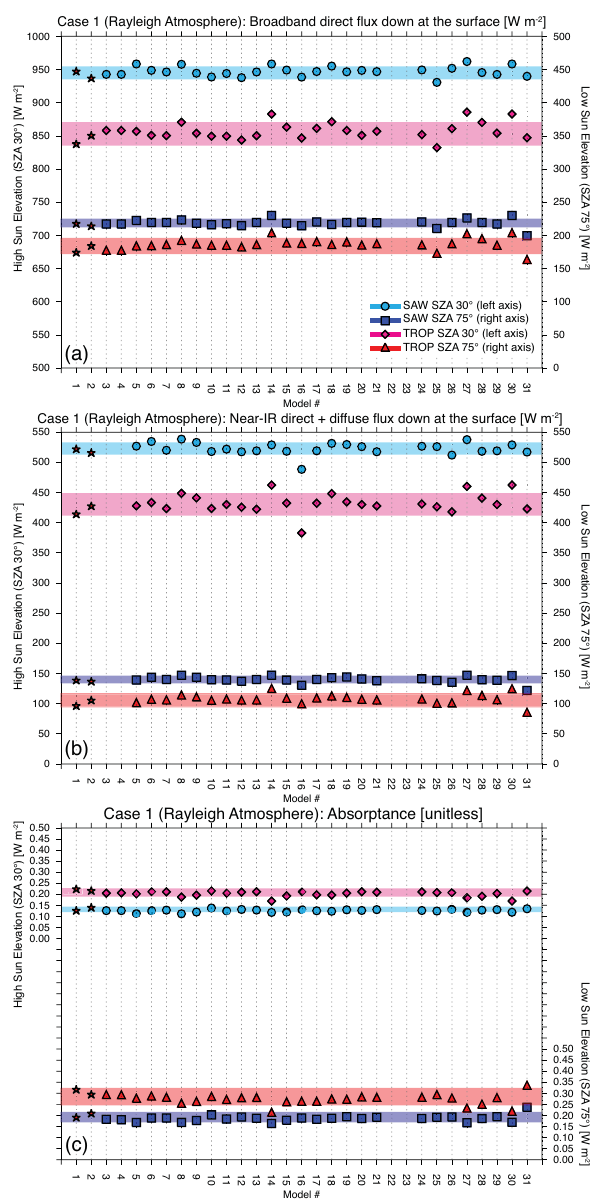
Fig. 2. Summary of results for Case 1 (Rayleigh Atmosphere) in Wm − 2 : (a) direct broadband flux down at the surface, (b) total (direct plus diffuse) near-IR down at the surface (calculated as the difference between broadband and UV-VIS), and (c) broadband ab- sorptance calculated as in Eq. (1). Line-by-line results (stars) and non-LBL results (non-stars) are given as a function of Model # (Ta- ble 1). Shading represents the greater of ± 1 standard deviation from the LBL or non-LBL mean. Normalized results were scaled by the following broadband (UV-VIS) TOA downwards fluxes: 1189.28 (563.38)Wm − 2 for SZA 30 ◦ and 355.43 (168.37)Wm − 2 for